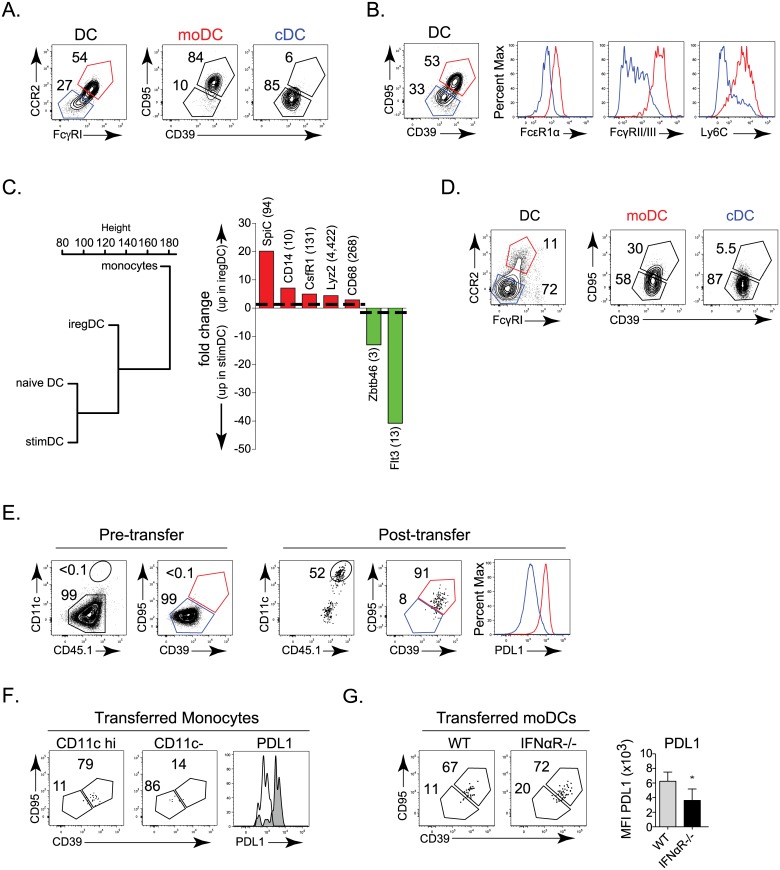
Suppressive iregDC are of monocyte origin.
A. Flow plots show CCR2 and FcγRI expression on splenic CD11b+ DCs on day 9 after LCMV-Cl13 infection. CCR2+, FcγRI+ (red) and CCR2-, FcγRI- (blue) populations are subsequently plotted on iregDC markers CD95 and CD39. B. Expression of FcεR1α, FcγRII/III, and Ly6C on iregDCs (red) and stimDCs (blue) gated on CD95 and CD39 from CD11b+ DCs on day 9 after LCMV-Cl13 infection. C. Dendogram representing the gene expression profile relation between naïve monocytes, naïve DCs, iregDCs and stimDCs at day 9 of LCMV-Cl13 infection. Bar graph of the expression of key monocyte-associated (red) and conventional DC-associated (green) genes. Numbers in parenthesis indicate the RPKM value for the highest sample. D. Left flow plots depict CCR2 and FcγRI expression on splenic CD11b+ DCs at day 25 after LCMV-Cl13 infection. Right flow plots depict CD39 and CD95 expression gated on CCR2+, FcγRI+ (red) and CCR2-, FcγRI- (blue) populations. E. Monocytes were isolated from naïve WT CD45.1+ mice and transferred into WT CD45.2+ mice that had been infected for 3 days with LCMV-Cl13. Left flow plots show DC and iregDC marker expression on isolated monocytes prior to transfer (gated on CCR2+, Ly6C+, FcγRI+ cells). Right flow plots depict transferred monocytes on day 6 post-transfer (day 9 after infection; gated on CD45.1+, CCR2 +, FcγRI+, CD11b+ cells). Histogram represents the expression of PDL1 of the transferred monocytes based on iregDC (red) and stimDC (blue) gates. F. Naïve CD45.1+ monocytes were transferred into WT CD45.2+ mice that had been infected with LCMV-Cl13 for 19 days. Six days later (day 25 after infection), DC and iregDC differentiation were analyzed in the spleen. Flow plots are gated on the transferred CD45.1+, CCR2+, FcγRI+ cells and then into the CD11c high (DC) and CD11c- populations. The histogram shows the expression of PDL1 on the CD11c high (shaded grey) and CD11c- (solid black line) monocyte derived subsets 6 days after transfer. G. Naïve WT or IFNαR-/- monocytes were transferred into LCMV-Cl13 infected WT mice as in E. Flow plots show CD39 and CD95 expression on transferred monocytes in the spleen on day 9 after LCMV-Cl13 infection (gated on CCR2+, FcγRI+, CD11c++, CD11b+ DC). Bar graph indicates PDL1 expression on iregDCs derived from the transferred monocytes. Data are representative of 2 or more independent experiments each consisting of 3–4 mice per group. *, p<0.05. RNA-seq is from 1 experiment using samples each pooled from 10 mice per group.